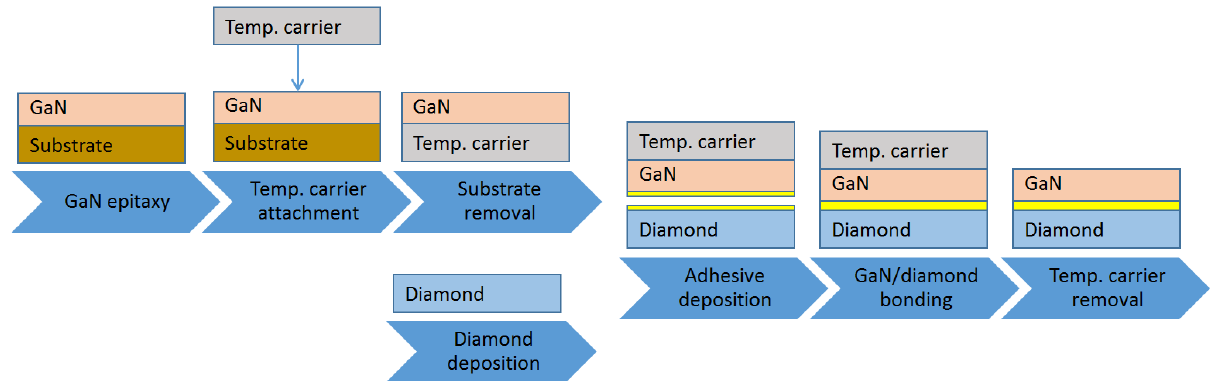
Figure 6. Bonding of GaN and diamond substrates.